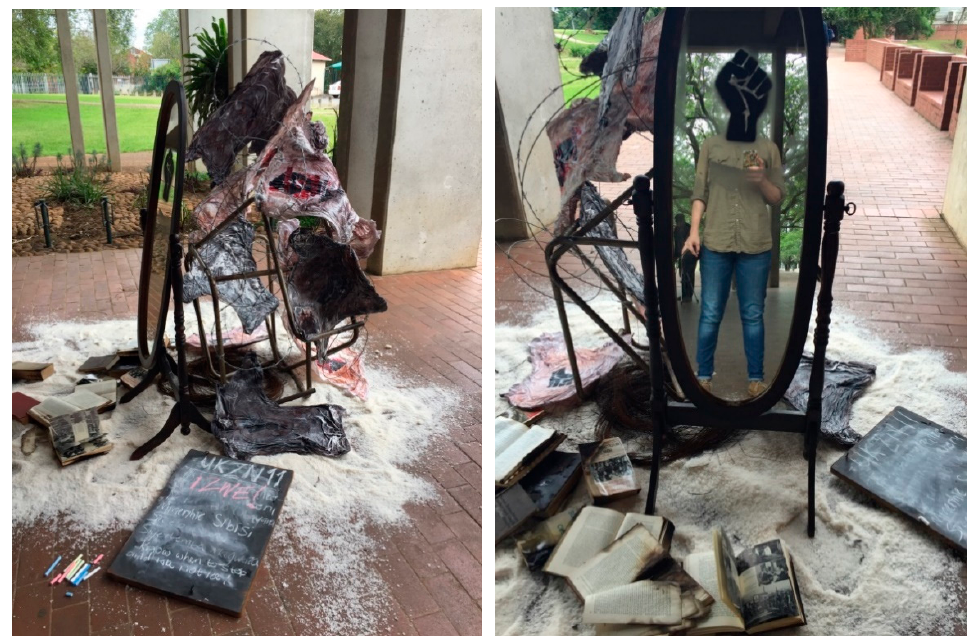
Figure 3. Public Sculpture.